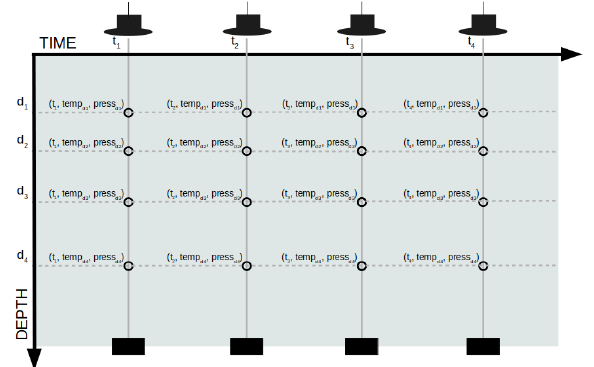
Figure 4 . The Profile observation